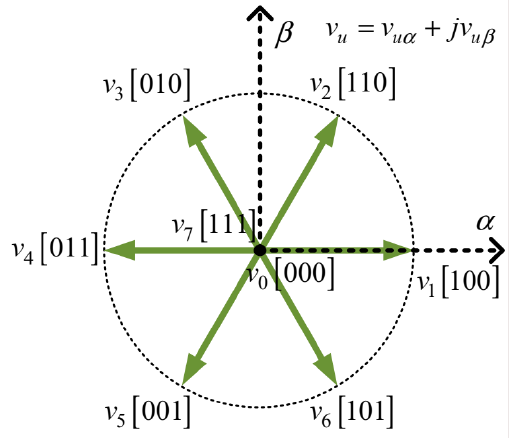
Figure 3. Possible voltage space vectors in the α − β